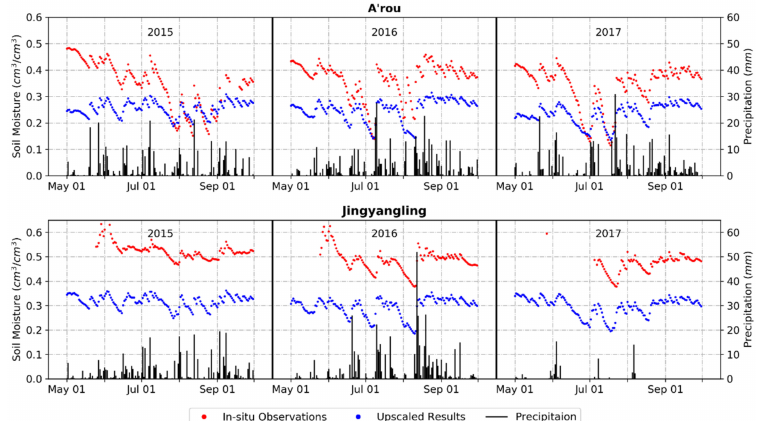
Figure 7. Comparison between the AMS (automatic meteorological station) observations and the upscaled